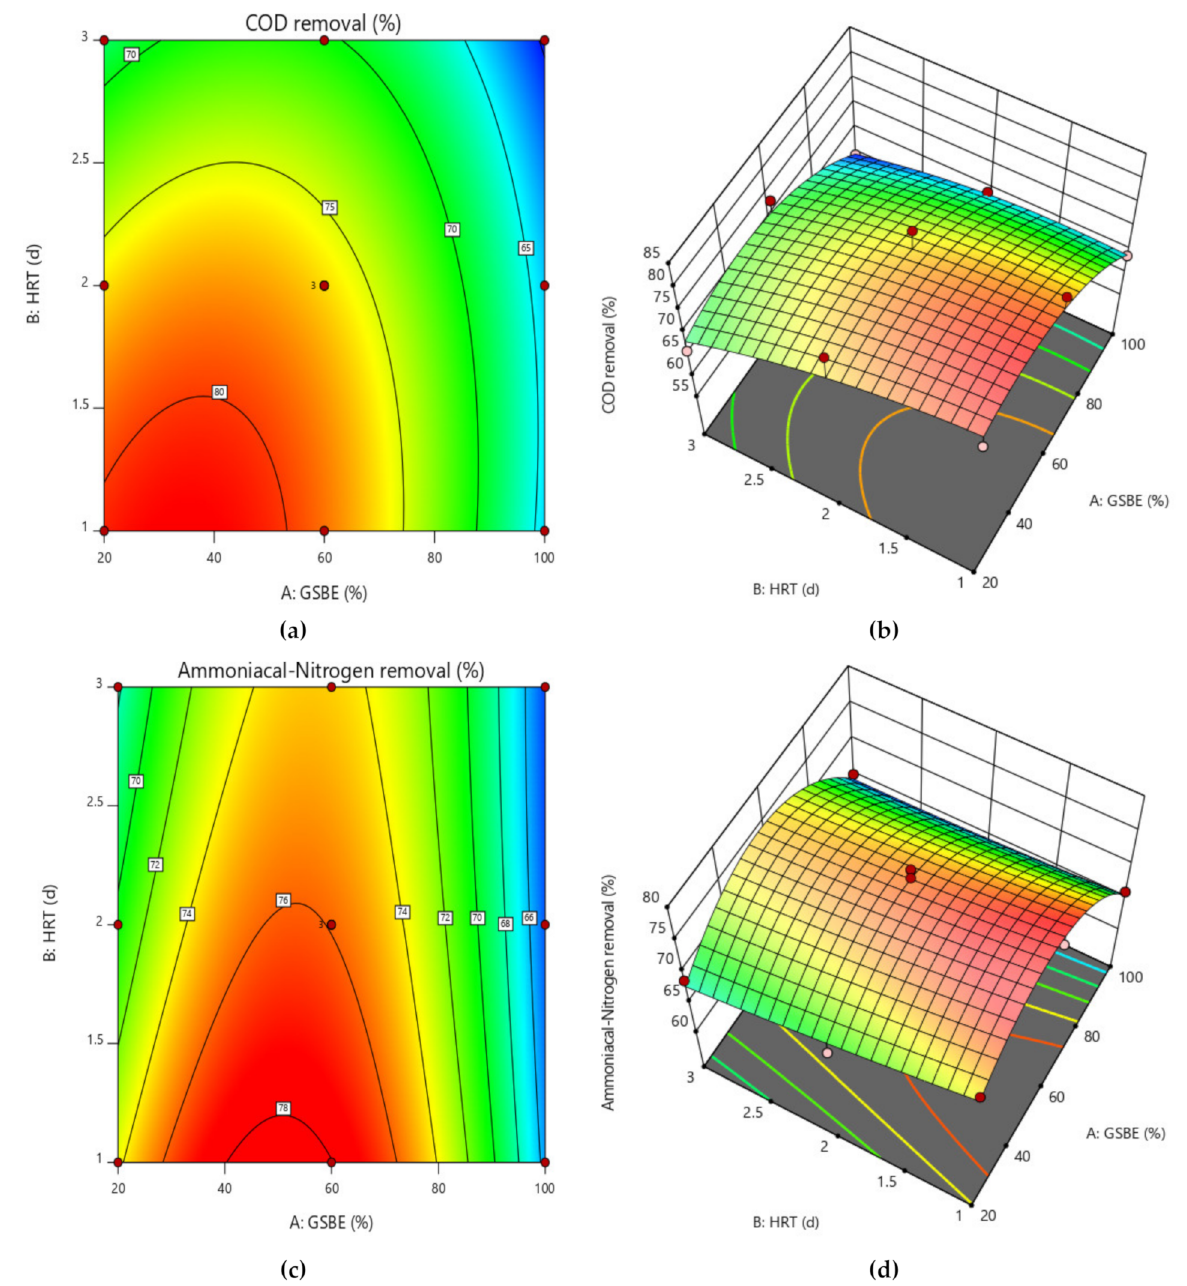
Figure 6. Contour and surface plot for ( a , b ) COD removal percent and ( c , d ) NH 4 + − N removal percent from the CMAS bioreactor